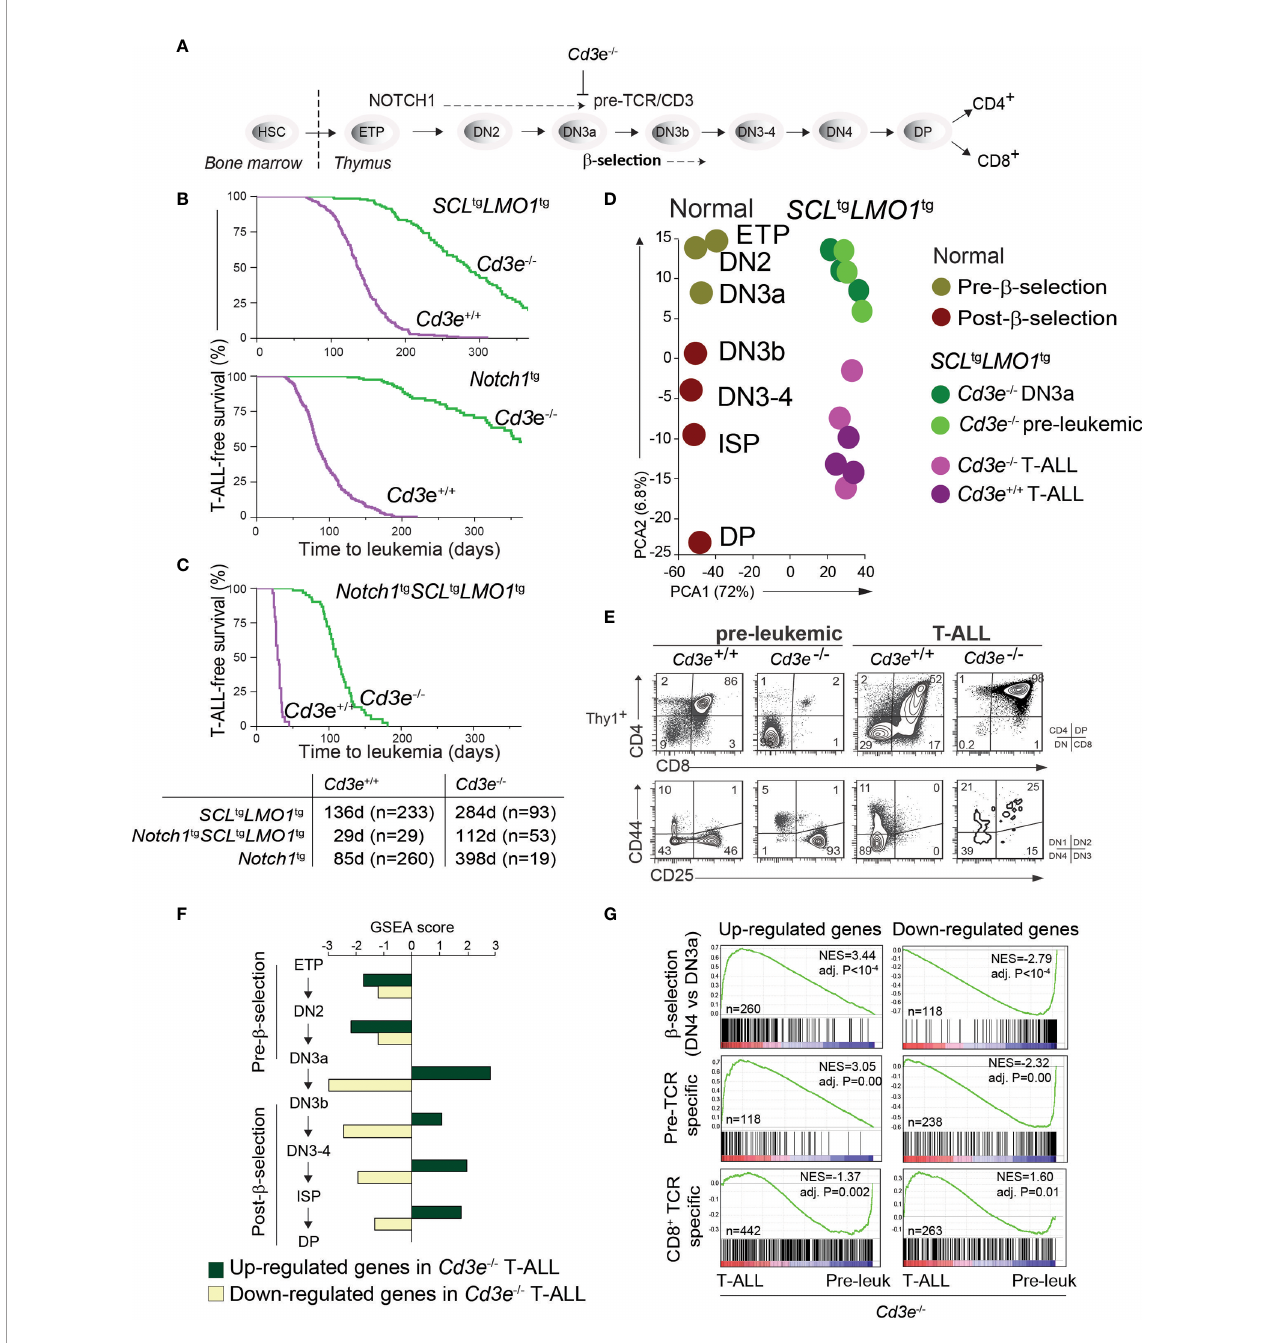
FIGURE 1 | Pre-TCR signaling is functionally important for T-ALL progression. (A) Pre-TCR signalling and thymocytes development. (B, C) Kaplan-Meyer survival curves comparing disease development in the pre-TCR pro fi cient ( Cd3e +/+ ) and de fi cient ( Cd3e -/- ) backgrounds in three models of T-ALL. (D) Principal component analysis of the transcriptomes of normal thymocyte subsets compared to SCL-LMO1-induced pre-leukemic and leukemic (T-ALL) thymocytes. (E) FACS phenotypes of SCL tg LMO1 tg thymocytes from Cd3e +/+ and Cd3e -/- backgrounds at pre-leukemic and leukemic stages. (F) Gene set enrichment analysis (GSEA) correlates disease progression to stages of thymocyte differentiation. Up-regulated and down-regulated gene sets were computed at each stage of normal thymocyte development from ETP to DP using microarray data from the Immgen project (http://www.immgen.org/), and enrichment was tested during disease progression (pre-leukemia to leukemia). Dark green bars denote enrichment of the up-regulated signature, and yellow bars denote enrichment of down-regulated signatures. (G) GSEA analysis of b -selection, pre-TCR speci fi c and CD8+ TCR speci fi c gene signatures during disease progression. Left panels show the enrichment tests for up-regulated gene signatures, and right panels show enrichment of genes decreased by b -selection, pre-TCR and CD8+